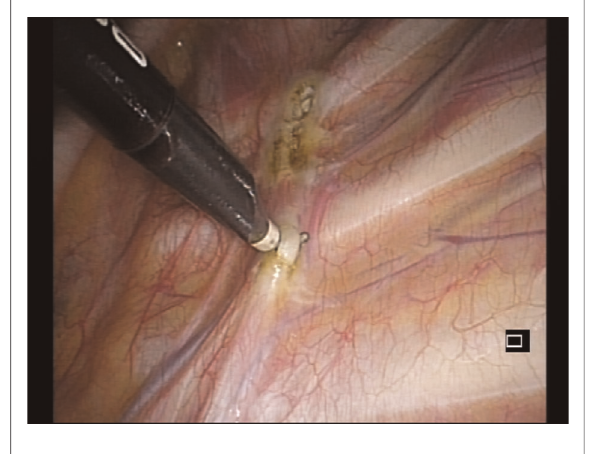
FIGURE 1 Identi fi cation of the sympathetic